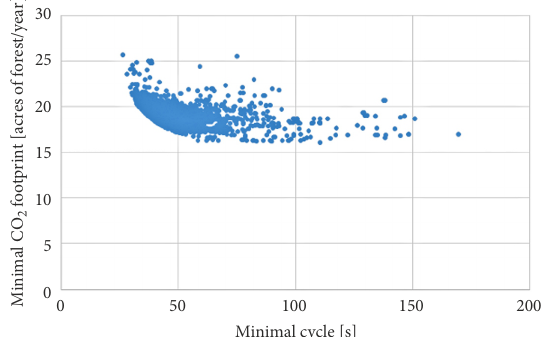
Figure 5. Results relation of minimal “CO 2 footprint” and minimal “cycle